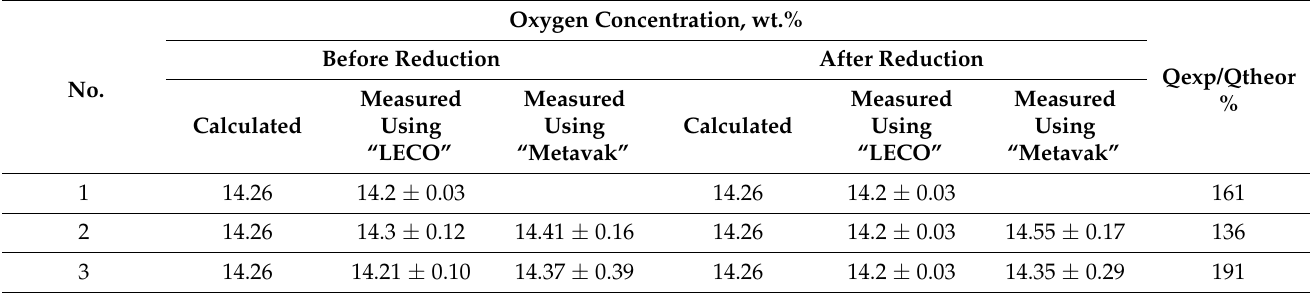
Table 8. Calculated and experimental values of the oxygen concentration in the Nd 2 O 3 pellets before and after the reduction.